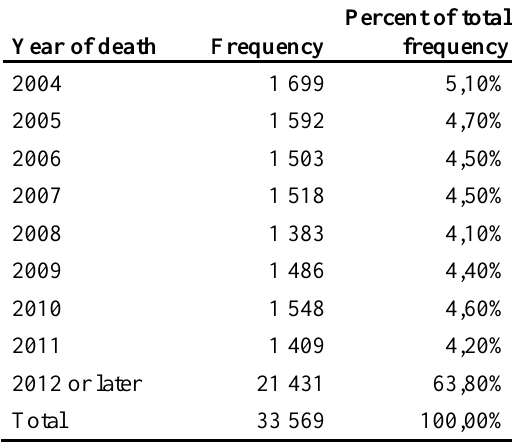
cardiovascular drug prescriptions among people with any 2003 cardiovascular drug prescriptions was 8.3.